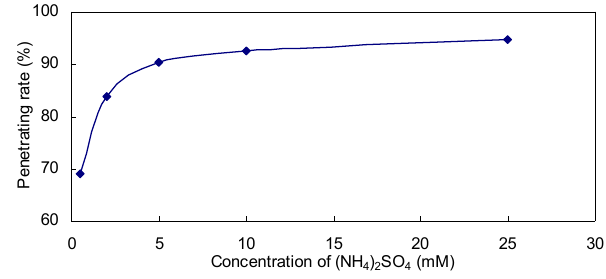
Fig. 6. Aerosol collection efficiency versus (NH 4 ) 2 SO 4 concentra- tions used for particles Fig.6. Aerosol collection efficiency versus (NH 4 ) 2 SO 4 concentrations used for particles generation